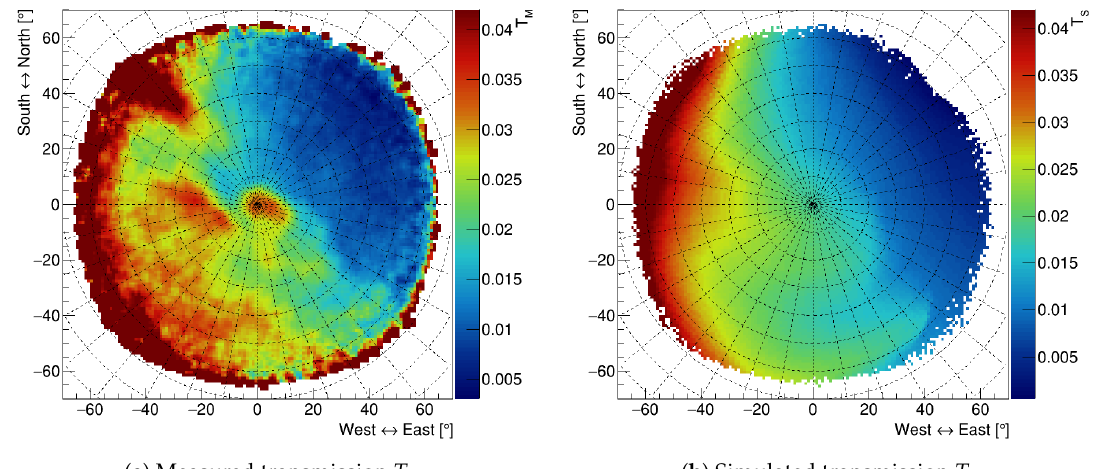
Figure 5. Measured and simulated muon transmission in the polar reference frame. For the measured transmission, a smoothing algorithm was used to reduce the statistical fluctuations and enhance the correlation between adjacent bins. For the simulated transmission, we used ¯ ρ ( θ , ϕ ) = 3 g/cm − 3